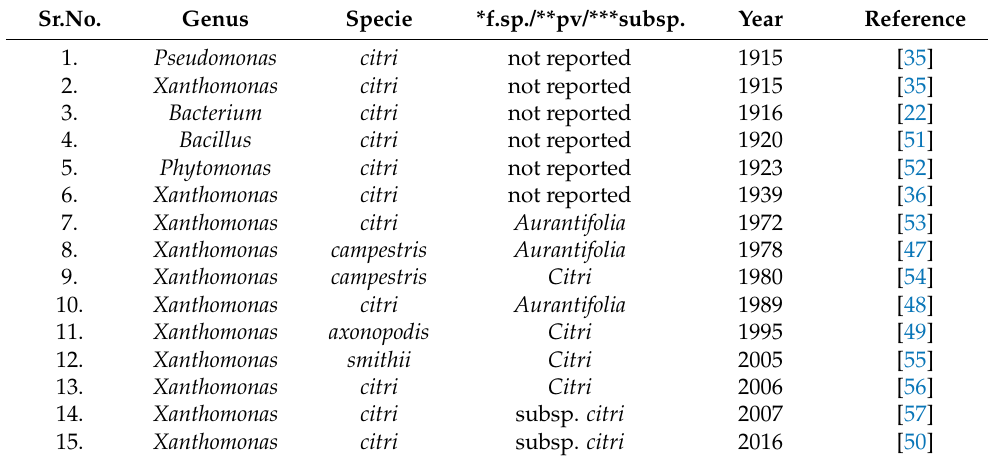
Table 1. X. citri subsp. citri Asiaticum (Canker A) classification details, from the start of the studies. Sr.No. Genus